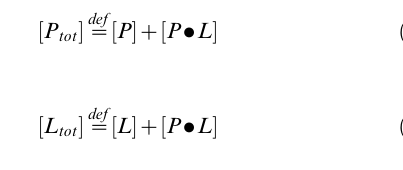
Figure S1 The X-ray bound structure of LAO (PDB ID: 1LAF) from four different viewing angles shows that the protein completely encloses the ligand. Thus, unbound ligands cannot enter the binding site when the protein is closed. Figure S2 (a) Opening and (b) twisting angles used to describe the motion of the protein. (c). The projection of conformations on the second eigenvector from Principle Component Analysis (PCA), and protein opening dihedral angle (see SI Sec 2 for detailed definition) as a function of time are shown in red and black respectively. The 20 ns simulation is started from protein in the closed state (PDB ID: 1LAF), but ligand was not included in the simulation. (d) Same as (c) except that the projection of conformations on the first eigenvector from PCA and protein twisting dihedral angle are plotted. In this system, the twisting and opening angles are correlated well with the first and second eigenvectors from PCA. Figure S3 Populations of top 23 most populated macrostates (macrostate-population . 0.1%) of the 54-state MSM. 1,000 conformations randomly selected from each macrostate are overlaid and shown from four different viewing angles. Free energy plots of the protein opening angle versus twisting angle (O, T) and the distance between the ligand and the binding site versus the opening angle (L,O) are displayed in red and blue respectively. The bin size is 5 u for ‘‘O’’ and ‘‘T’’ and 1.5 A˚ for the ligand distance. The interval between two adjacent contour levels is 0.5 KT. The green and blue crosses correspond to the X-ray bound and apo structures respectively. For the free energy plots the x and y axis-scales are the same than those found in the Fig. 2 of the main text. Figure S4 The three representative conformations from the encounter complex state based on RMSD of the (a) protein C- a atoms and (b) binding site plus the ligand (heavy atoms of the residues within a cutoff of 8 A ˚ from the ligand in the crystal structure with PDB ID: 1LAF) are compared to (c) the crystal bound structure of LAO (PDB ID: 1LAF). The protein is shown